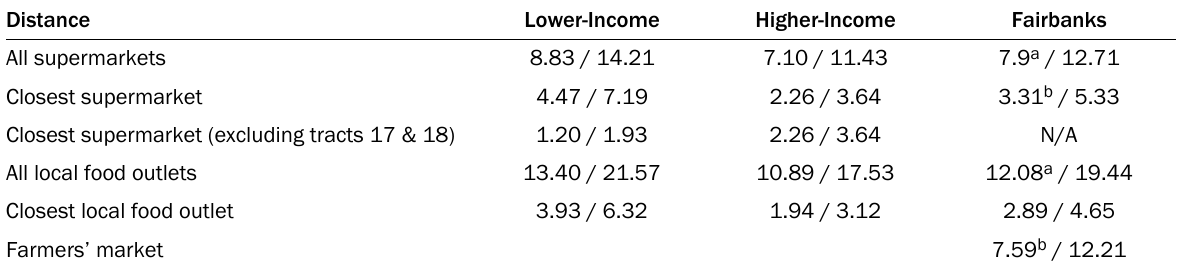
Table 3. Average Distance to Stores (in Miles and Kilometers) from Census Tract Population Centroids